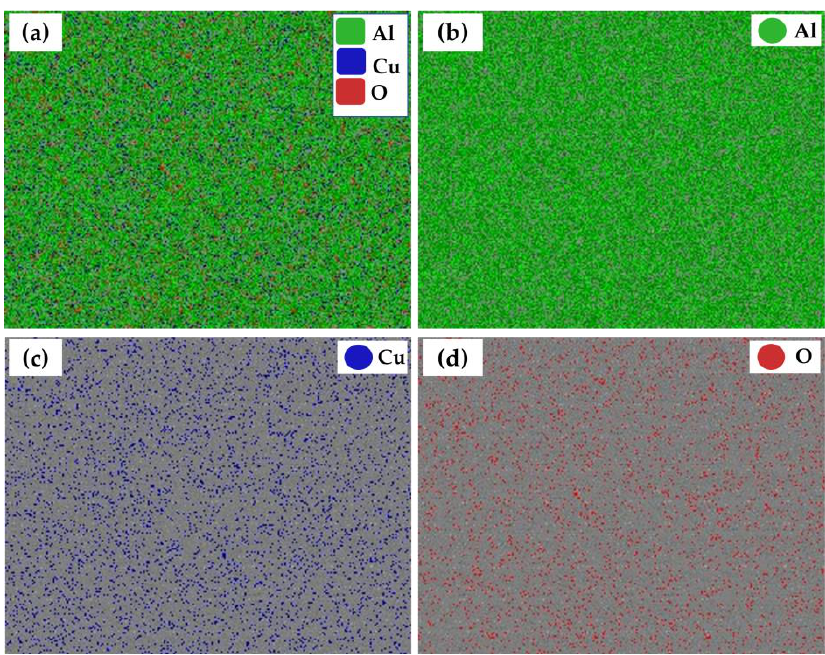
Figure 14. Elemental map distribution of the deposited AA2011/nano Al 2 O 3 composite.